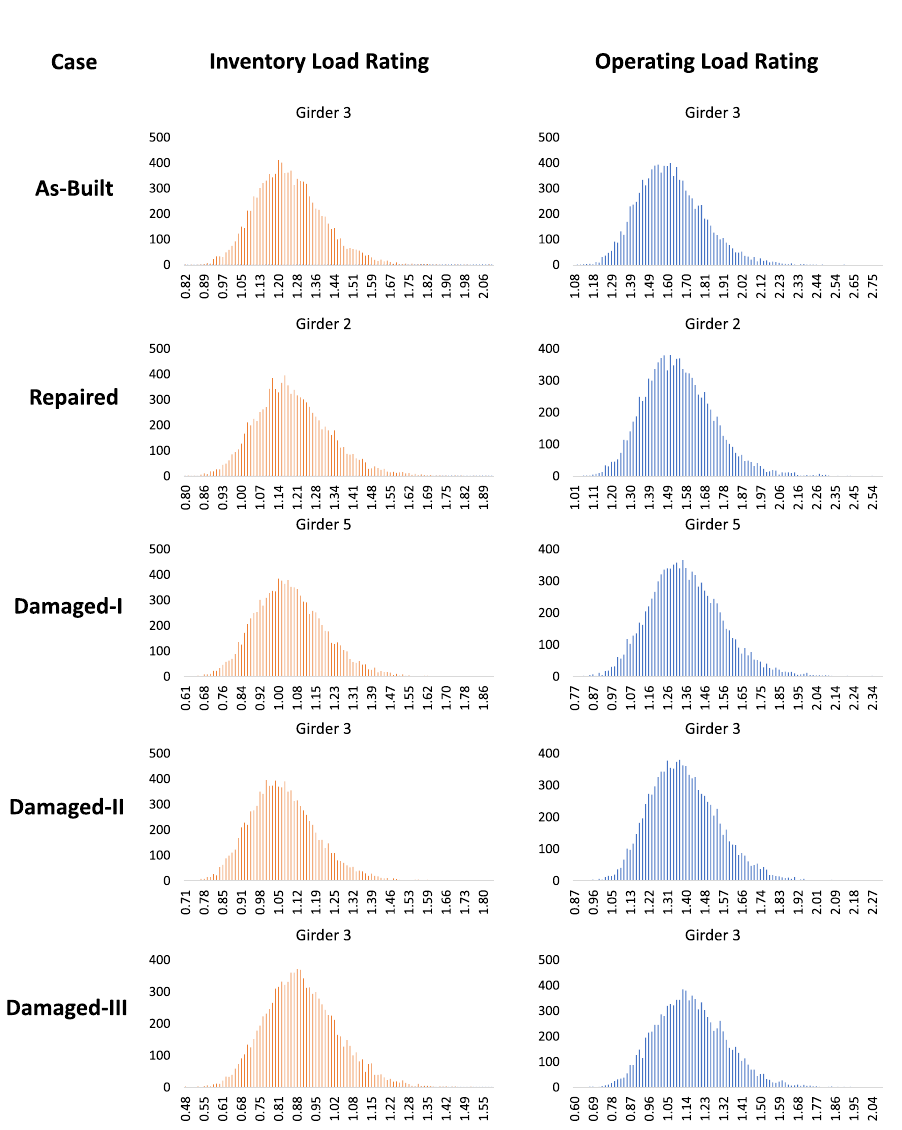
Fig. 11 The inventory and operating load rating distributions for different cases for the controlling girders as shown in Table